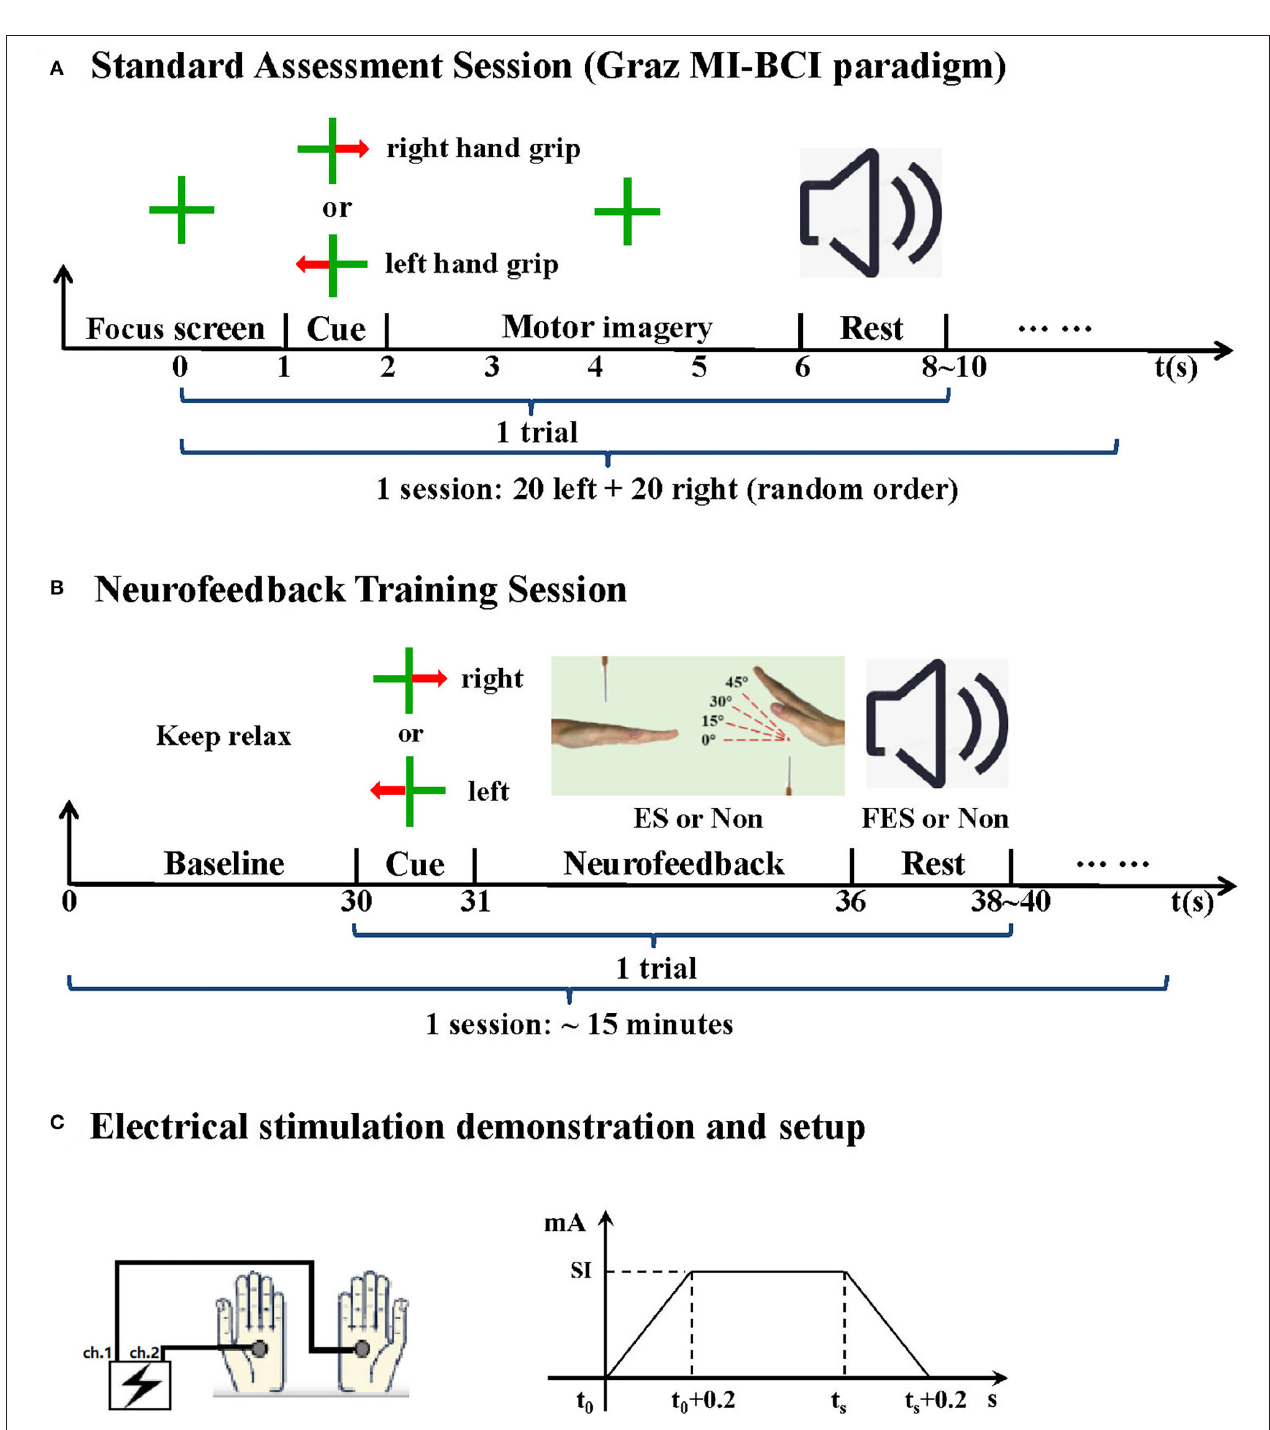
FIGURE 2 | Experimental paradigm. (A) Standard assessment session. (B) NFT session. (C) Electrical stimulation, SI indicates stimulation intensity individually determined, ts indicates the end time of current NFT trial or the time when the training feature parameter lower than the threshold again.